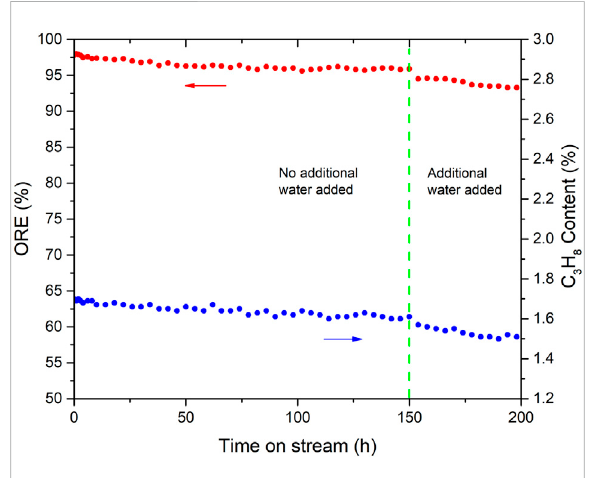
FIGURE 6 Long-term performance of the Pd-K/A catalyst (T = 240 ° C, p = 0.5MPa, LHSV = 4,000 h − 1